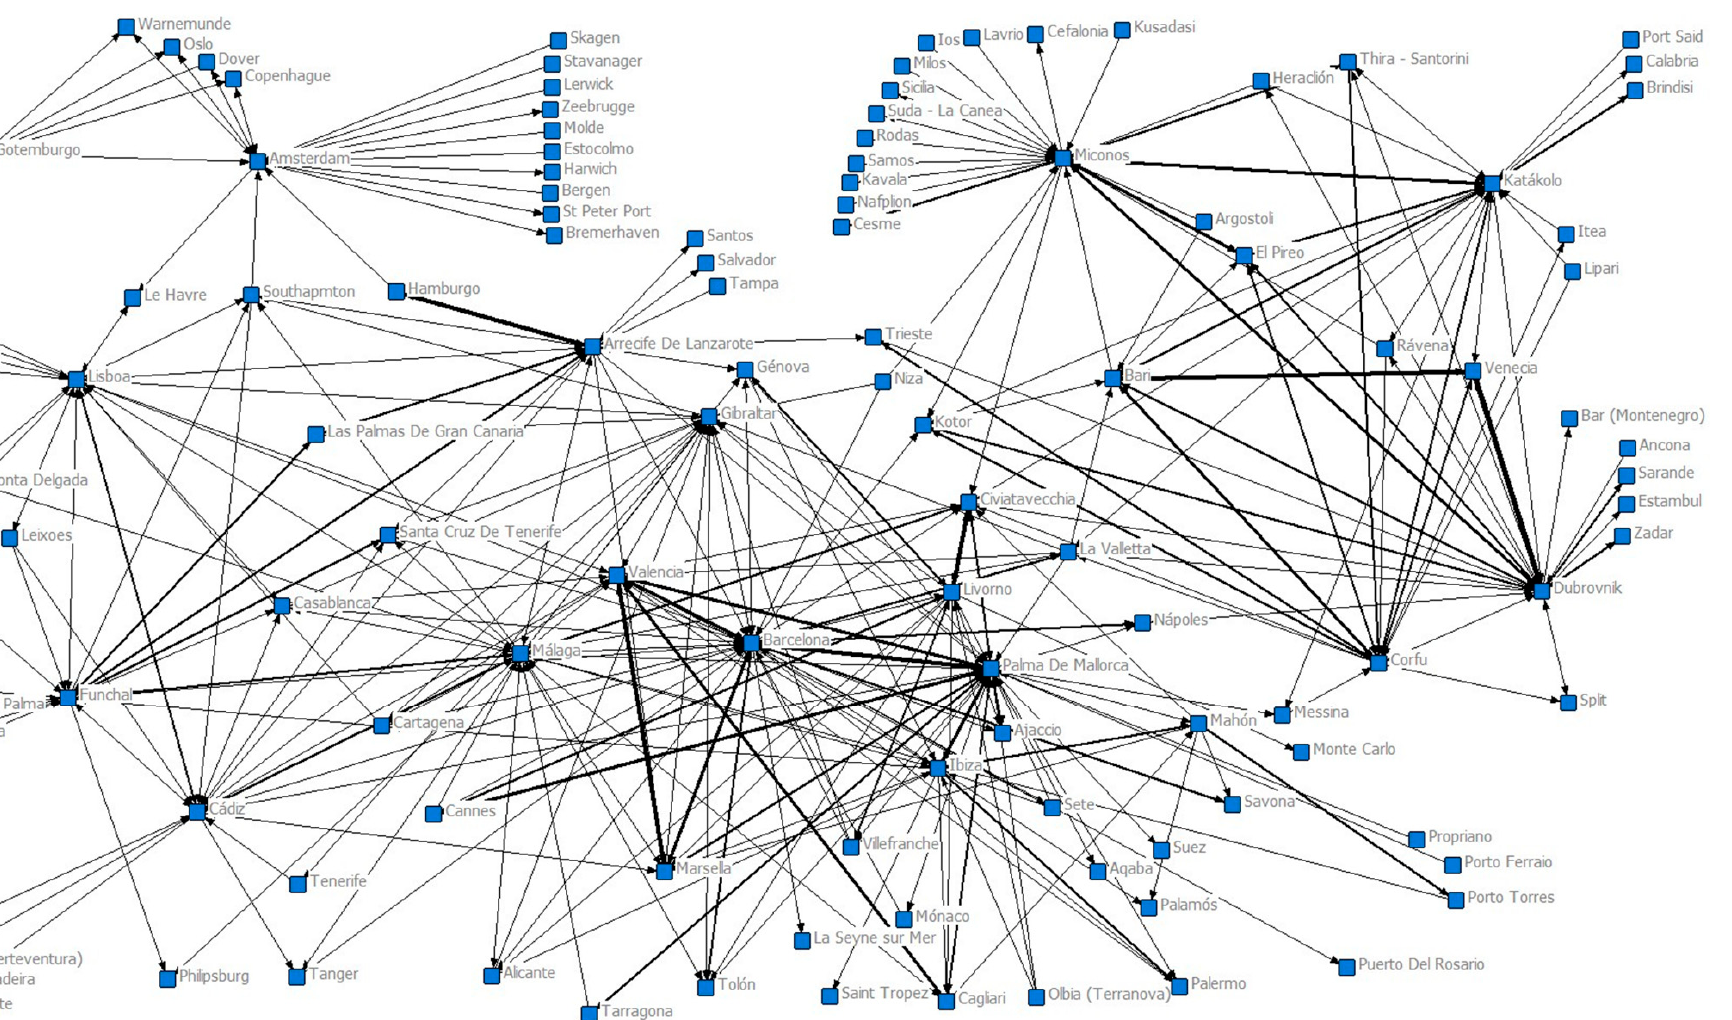
Figure 5. Interrelations of contemporary cruise port network in Southern Europe in 2017. Source: Authors elaboration. Note: The thickness of the lines indicates the traffic intensity between ports.